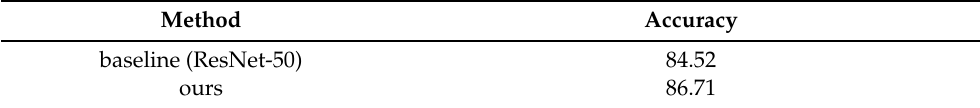
Table 5. Accuracy on small scale